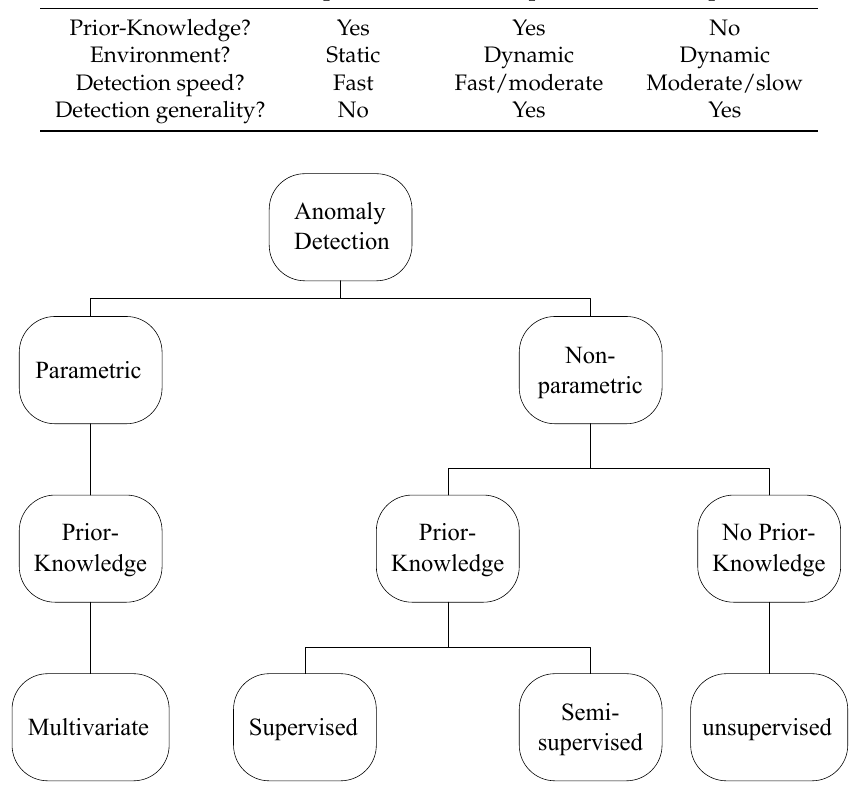
Figure 2. Anomaly Detection Summary.